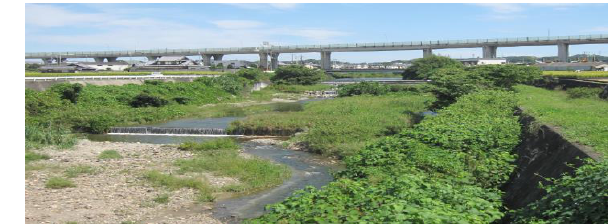
Figure 2. Measurement